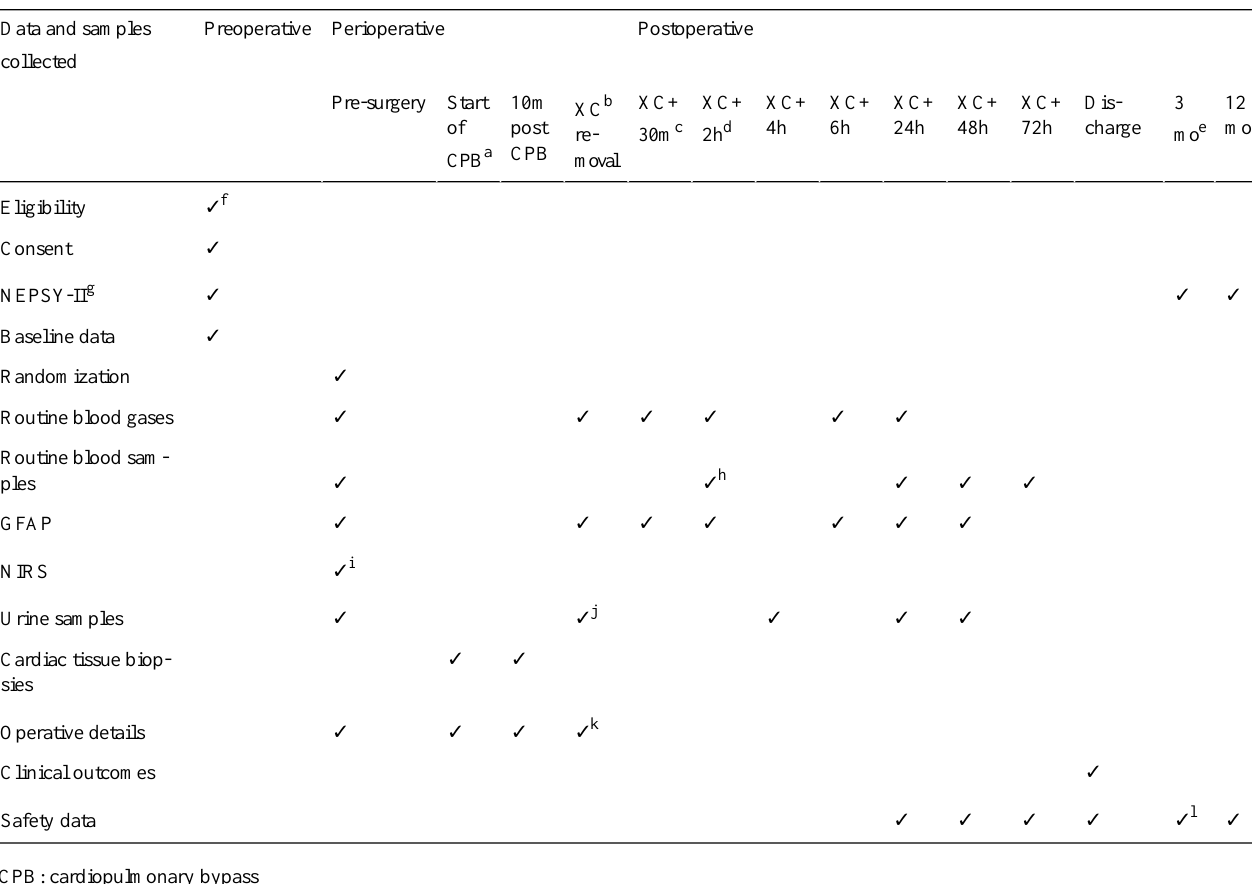
Table 1. Schedule of data and sample collection. PostoperativePerioperativePreoperativeData and